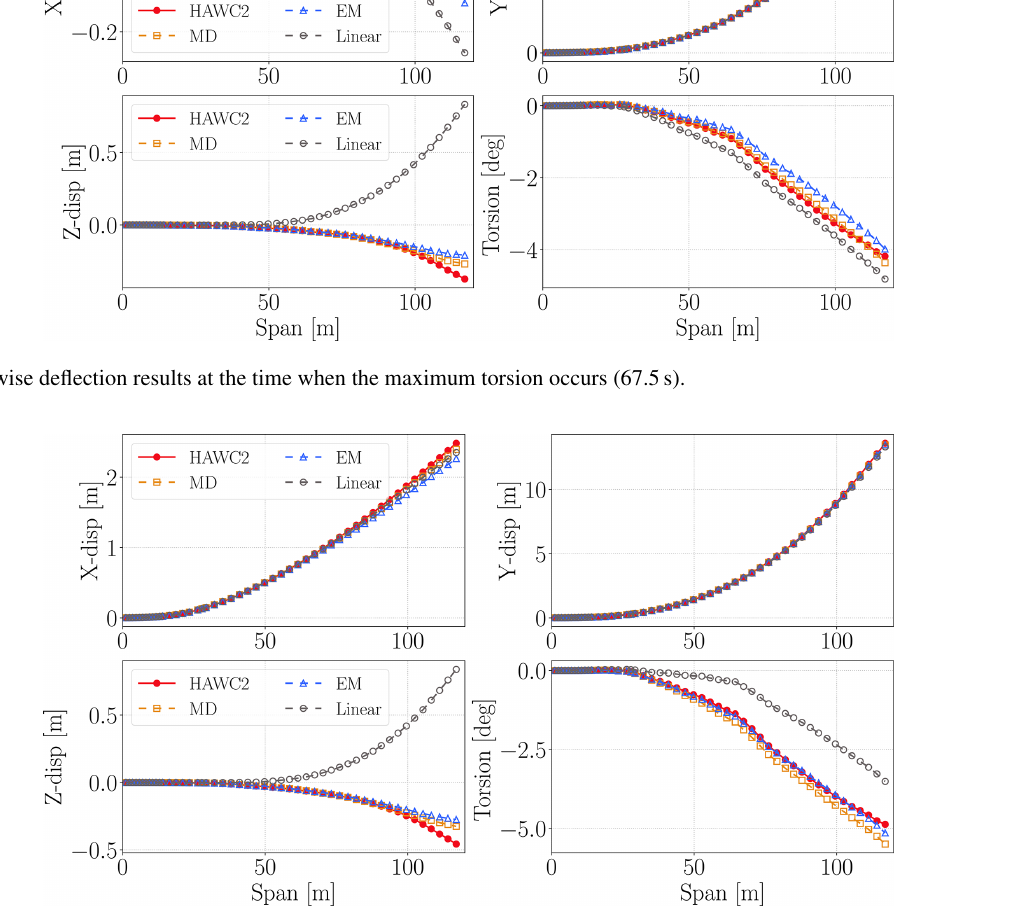
dated with deflection. In other words, the results are not